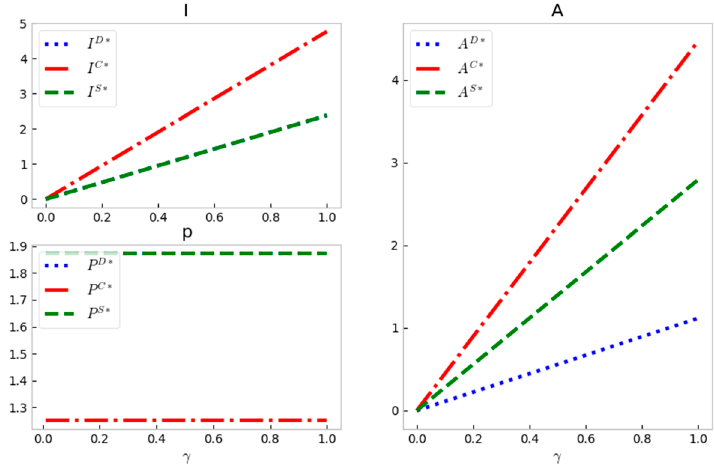
Figure 1. Impacts of γ on price, ecological effort and advertising effort.